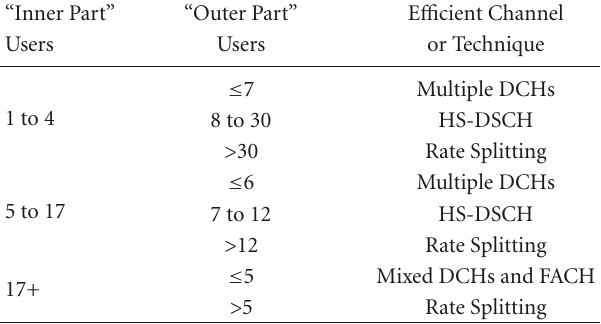
Table 6: Switching points and most e ffi cient techniques as a function of the “inner part”